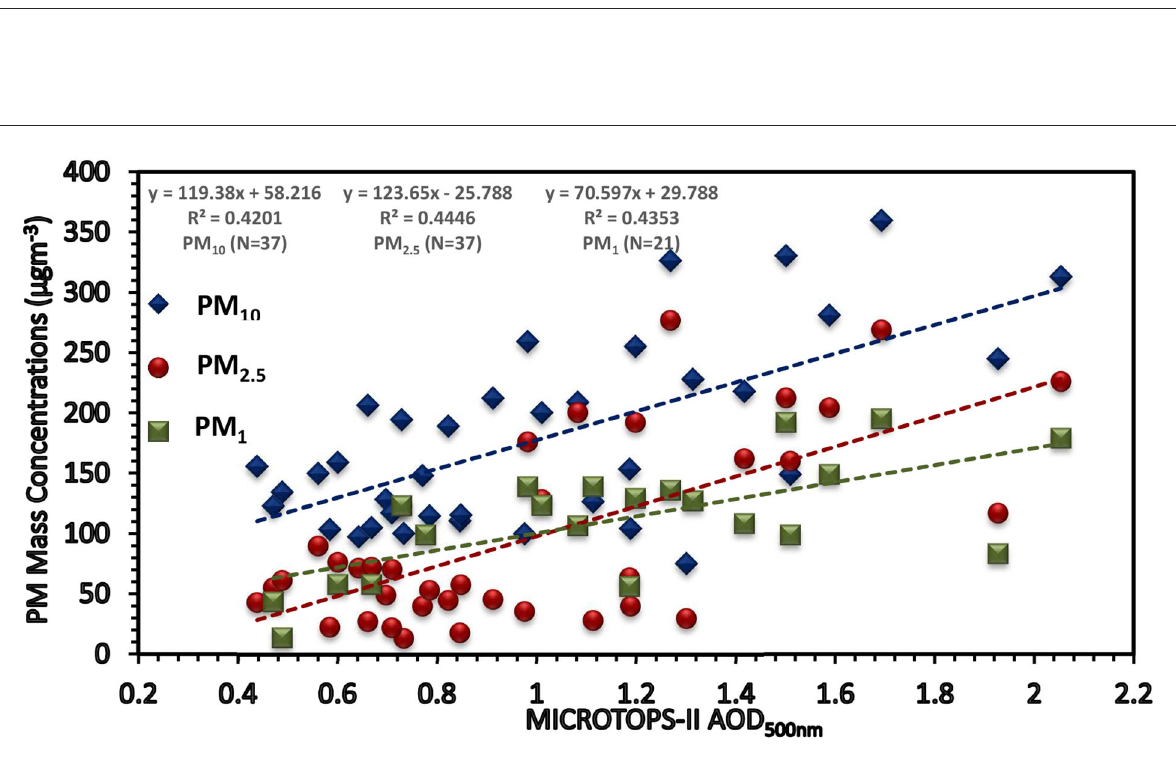
FrontiersinSustainableCities